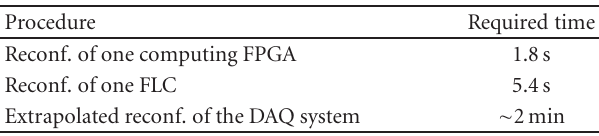
Table 2: JTAG reconfiguration times.